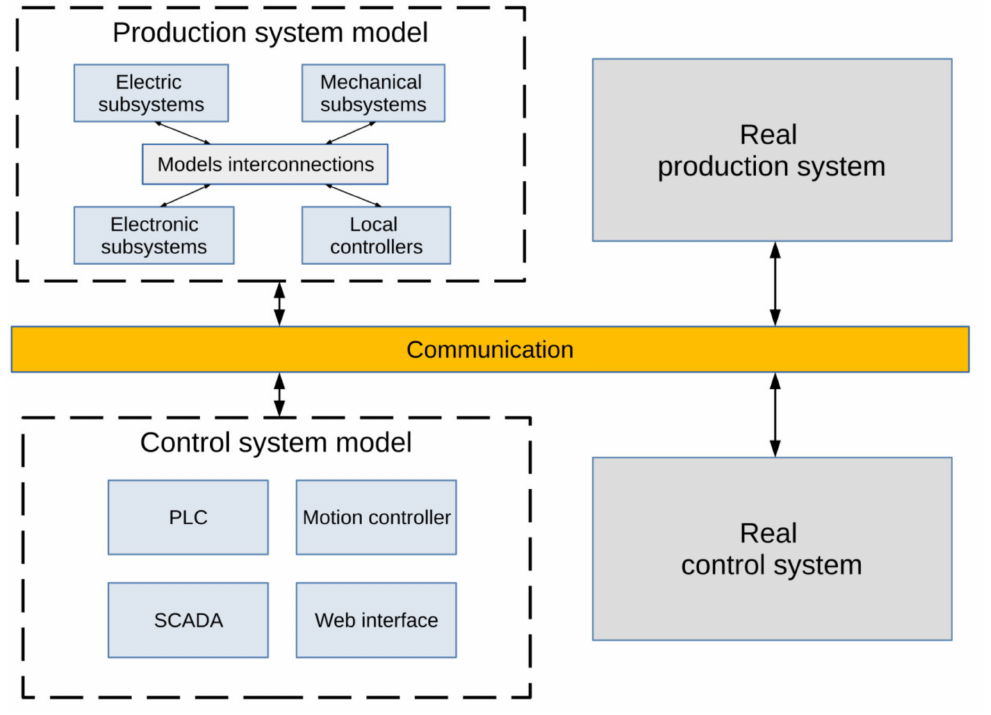
Figure 4. Structure of the Digital Twin system. Source: own